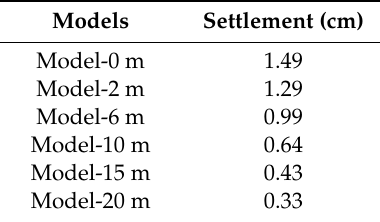
Figure 15. Foundation settlements. Table 5. Foundation